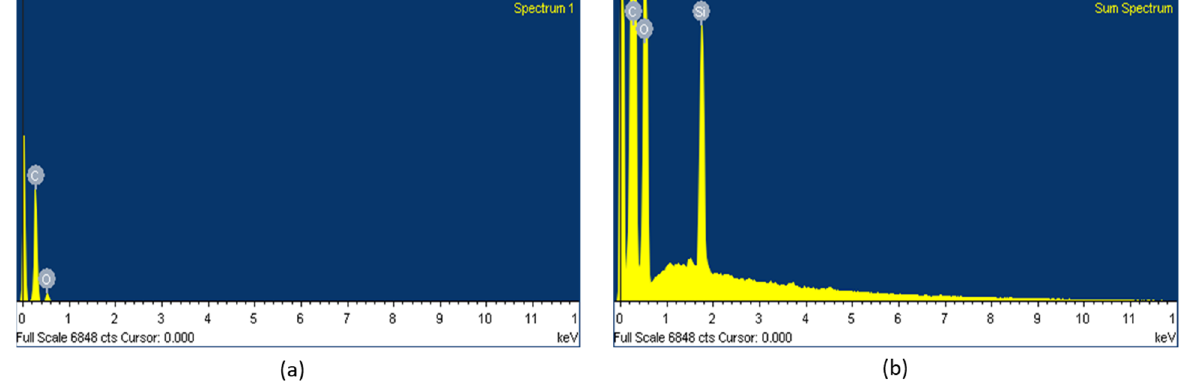
Figure 19. EDS spectra of fabrics coated with ( a ) 3238-3PDO and ( b ) 3238-3POSS.